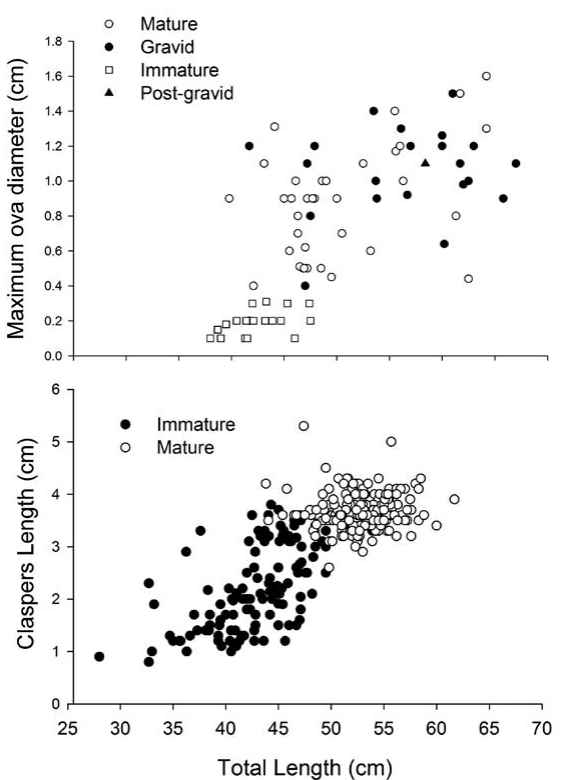
Fig. 5. – Maximum ovum diameter of females at different matu- rity stages (top) and male clasper length vs. total length (bottom), of Mustelus higmani captured by the artisanal fishery of Margarita Island, Venezuela from 2006 to